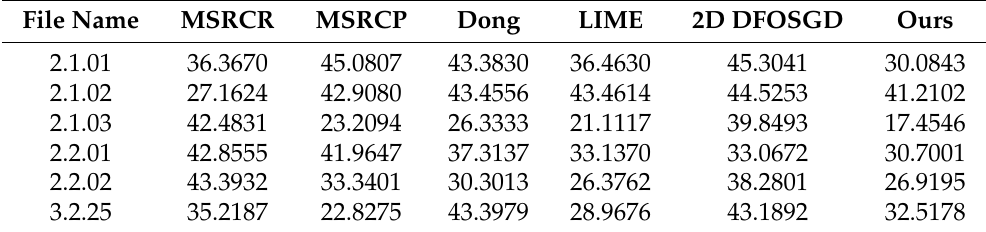
Table 5. The comparison of